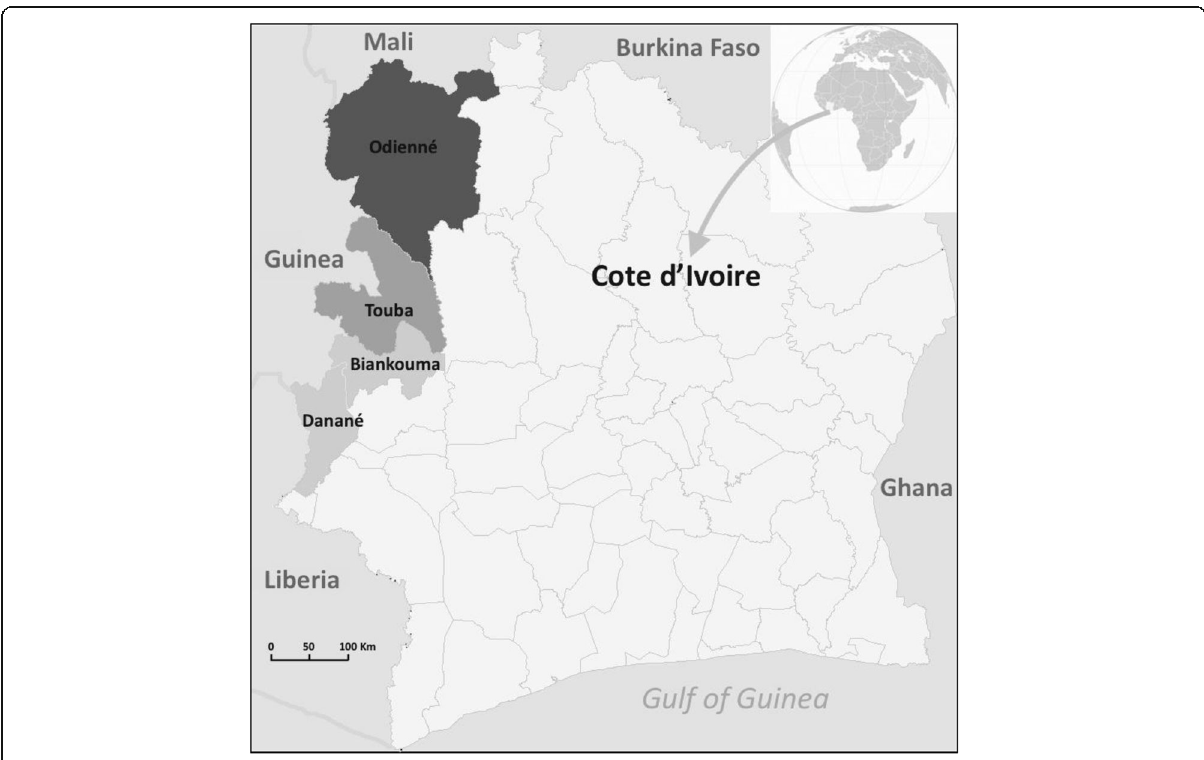
Fig. 1 Map of the four districts of Côte d ’ Ivoire included in the study. NB: The districts of Biankouma and Danané belong to the same region, i.e. Tonkpi region. Source: Adapted from Map of the departments of Côte d ’ Ivoire (Ivory Coast). Created by Rarelibra in 2007 for public domain use, using MapInfo Professional v8.5 and various mapping resources. Available from: